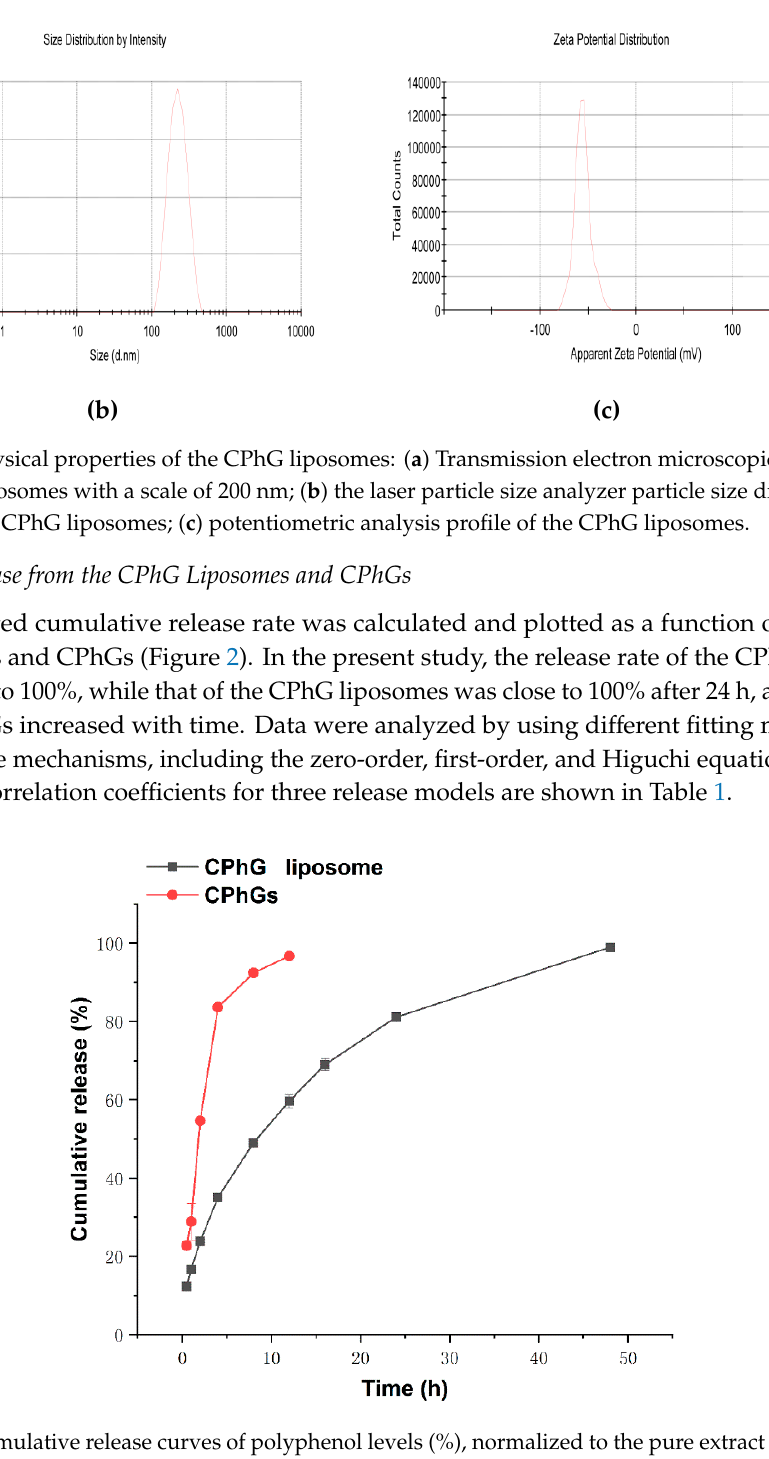
Figure 2. Cumulative release curves of polyphenol levels (%), normalized to the pure extract calculated as the echinacoside equivalents of CPhGs (100% release) for non-encapsulated CPhGs and the CPhG liposome over 48 h. Table 1. The results of fitting equation and coefficients.